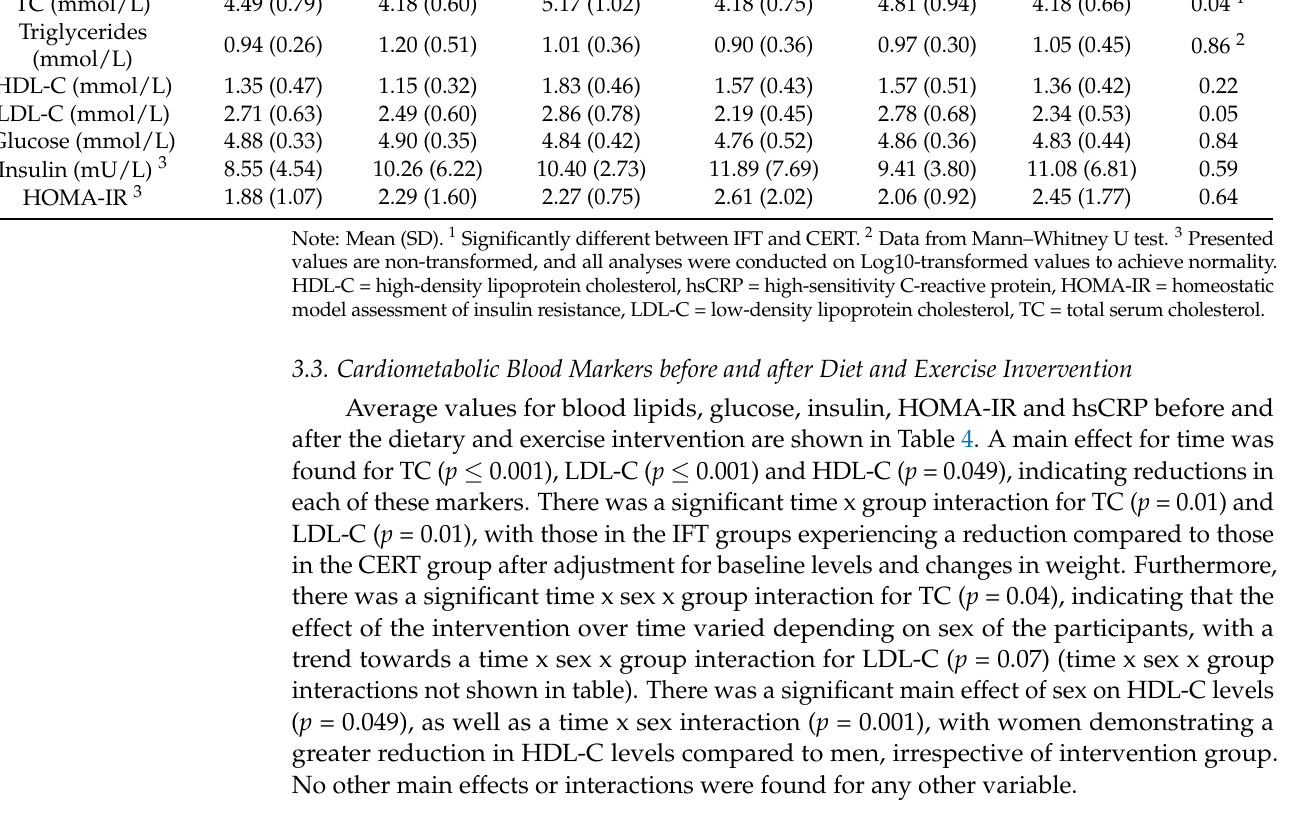
Table 4. The effects of 12 weeks of IFT or CERT with resistance exercise on cardiometabolic blood